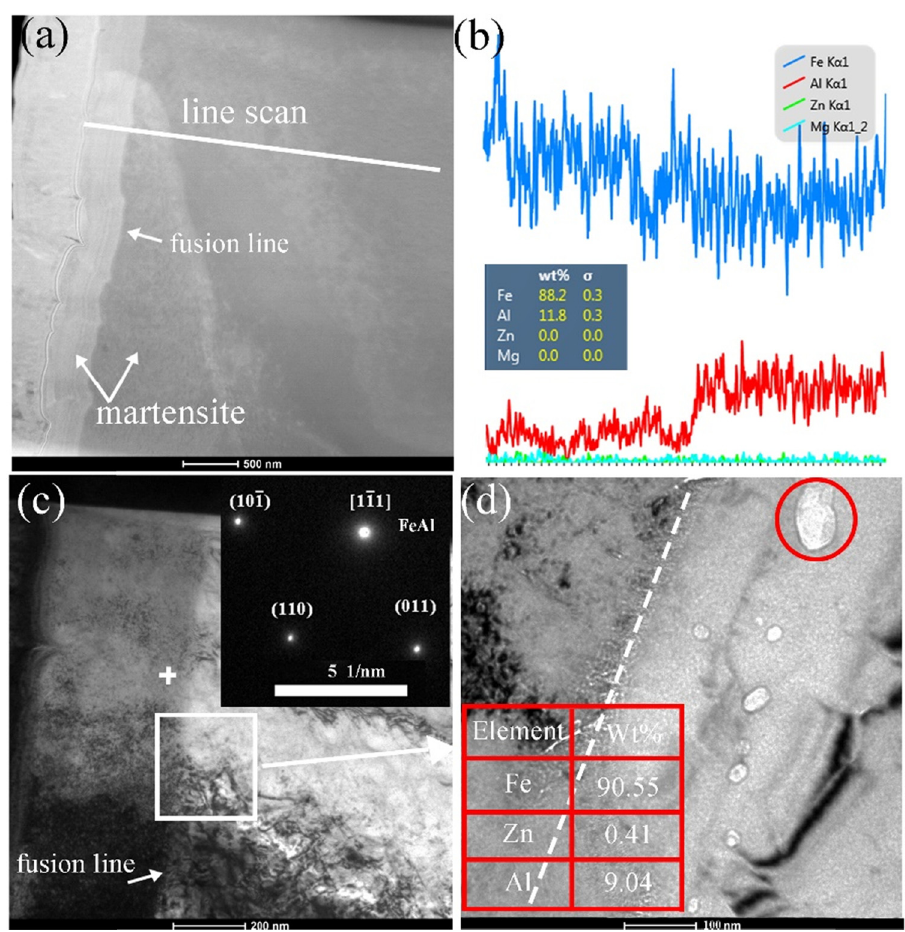
Figure 10: TEM images of HAZ - 3: ( a ) microstructural morphology of HAZ - 3; ( b ) line scanning; ( c ) and ( d ) SAED of unintegrated areas.